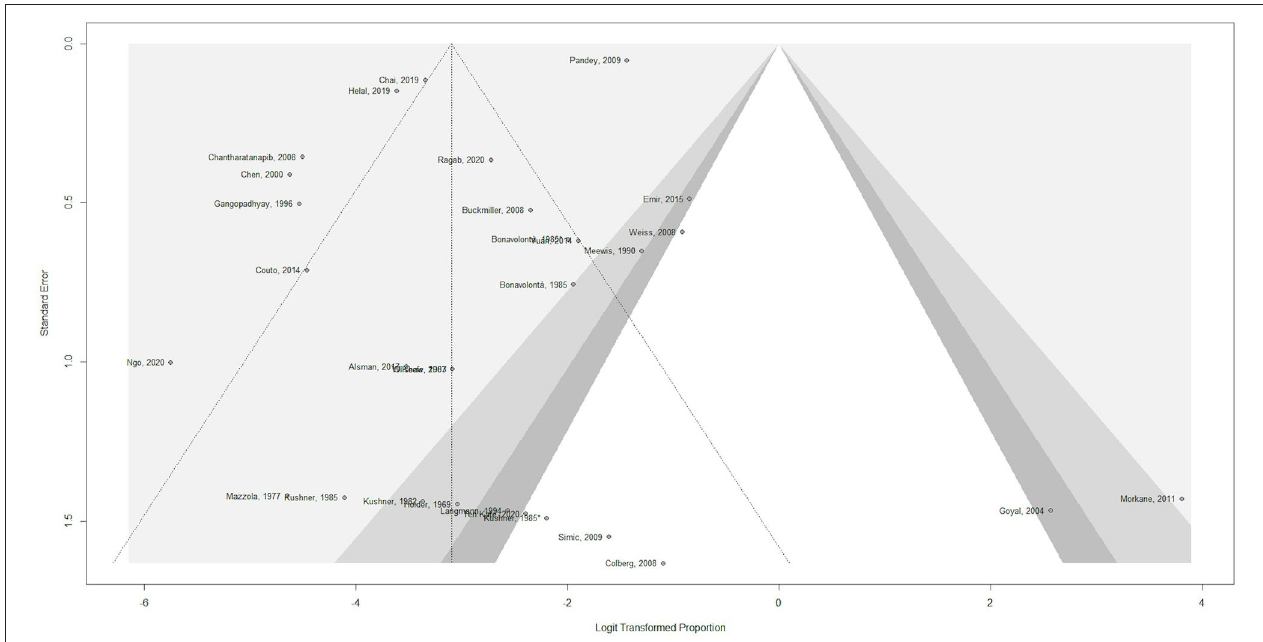
FIGURE 2 | Funnel plot for assessment of potential publication bias (12,